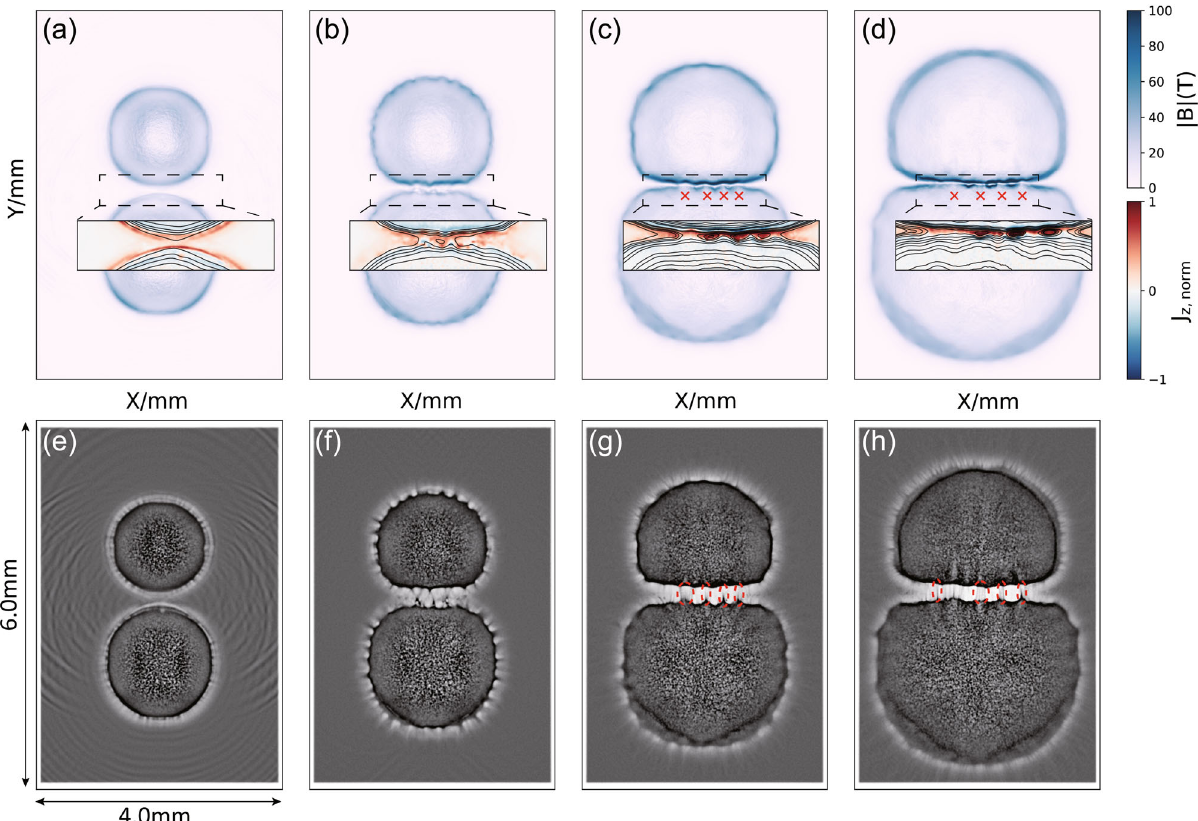
Fig. 4 Kinetic 2D3V particle-in-cell (PIC) simulation results of the hybrid magnetic reconnection. Here the initial conditions are taken from the RMHD (radiation-magnetohydrodynamic) simulation at z = 400 μ m, and at t = 0.8 ns [see Supplementary Fig. 2]. a – d are distributions of the magnetic fi eld strengths ∣ B ∣ (in white-blue color bar) at time t = 1.0, 1.2, 1.5, 1.8 ns respectively during the magnetic reconnection. The zoomed images show the out of plane current densities J z (in blue-red color bar, normalized to 1 × 10 14 , 4 × 10 14 , 6 × 10 14 , 10 × 10 14 A ⋅ m − 2 respectively) and vector potential A z (contours) of the reconnection region, corresponding to the dashed box regions in ( a – d ) respectively. e - h show the corresponding synthetic proton radiography images based on the magnetic fi elds ( a – d ) obtained from PIC simulations (more details see Methods), where the higher the grayscale represents the higher the proton doses. The radiography geometric magni fi cation M and proton energy E p are consistent with the realistic experimental radiography setup. In order to match the extracted path-integrated magnetic fi elds ψ , the thickness of the fi elds is taken as d ~ 100 μ